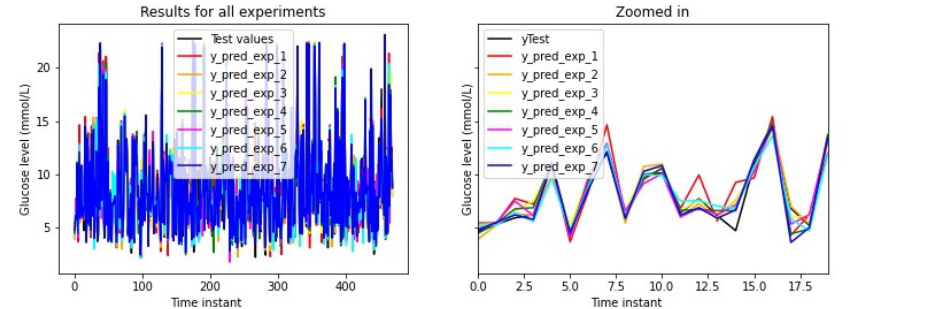
Figure 10. Experiment 1 boxplot scores, from 10 executions for each patient and configuration.